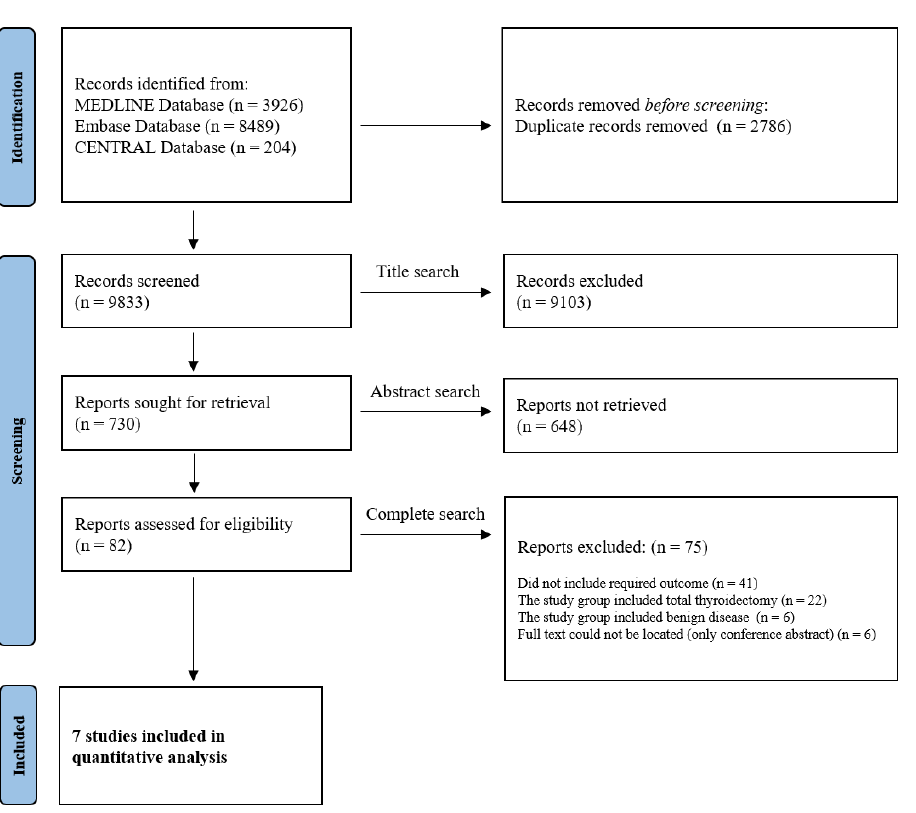
Figure 1. Flow diagram showing the selection of studies for inclusion in the systematic review and